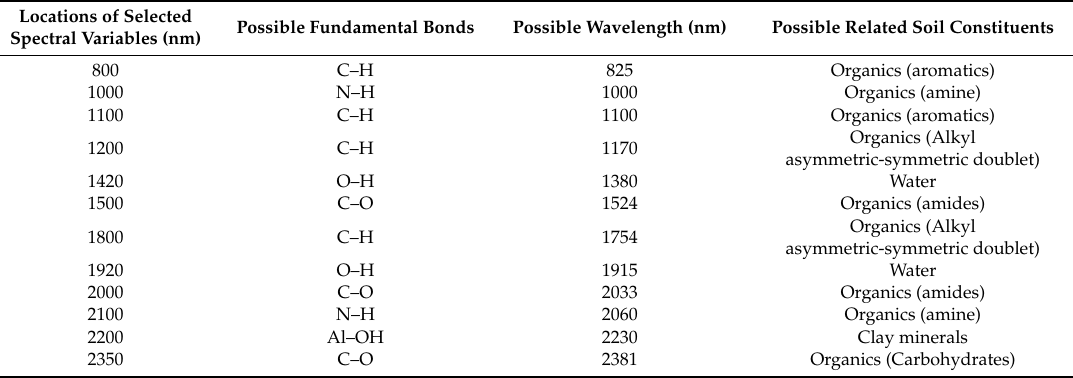
Table3. Possibleassignmentsoffundamentalbonds, absorptionwavelength, andrelatedsoilconstituent for the selected spectral variables in the near-infrared region by competitive adaptive reweighted sampling (CARS) and random frog (RF)